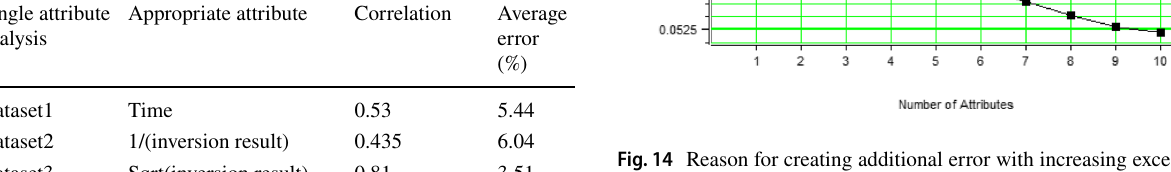
Fig. 14 Reason for creating additional error with increasing